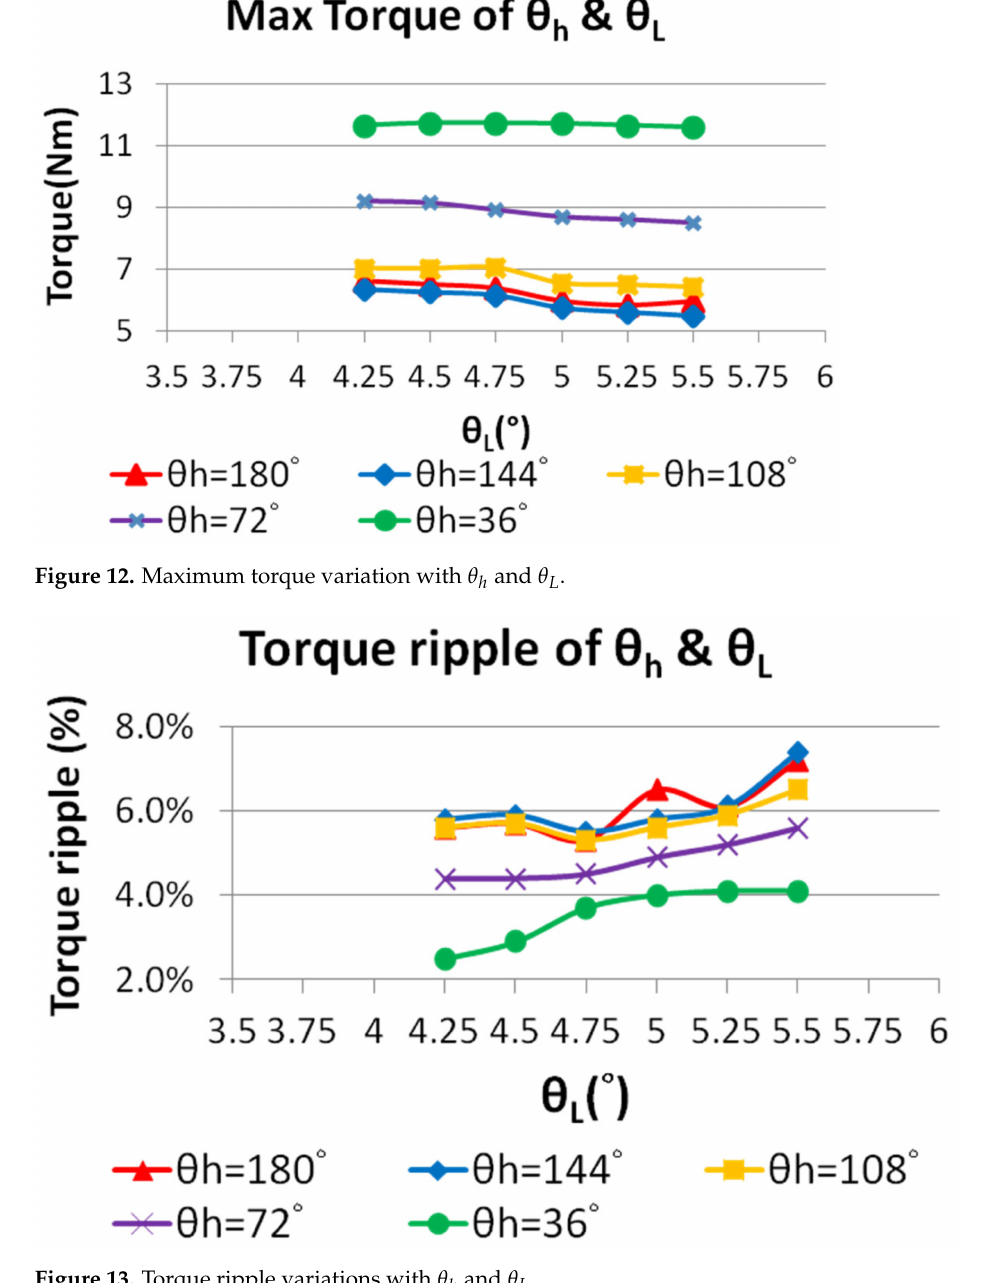
Figure 13. Torque ripple variations with θ h and θ L